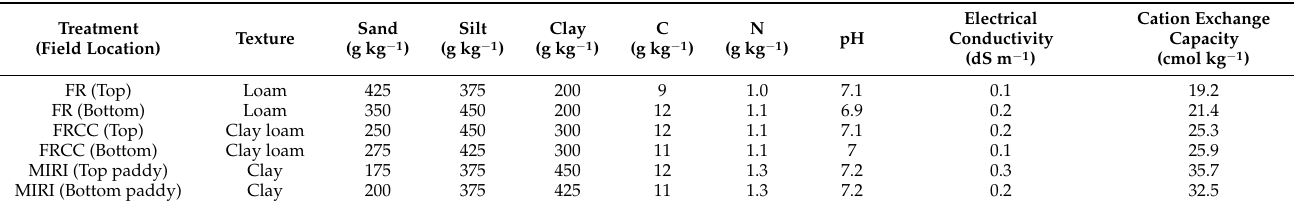
Table 2. Soil characteristics (0–25 cm) from furrow-irrigated rice (FR), furrow-irrigated rice with winter cover crops (FRCC) and multiple-inlet rice irrigation (MIRI) fields studied in northeast Arkansas. Treatment (Field